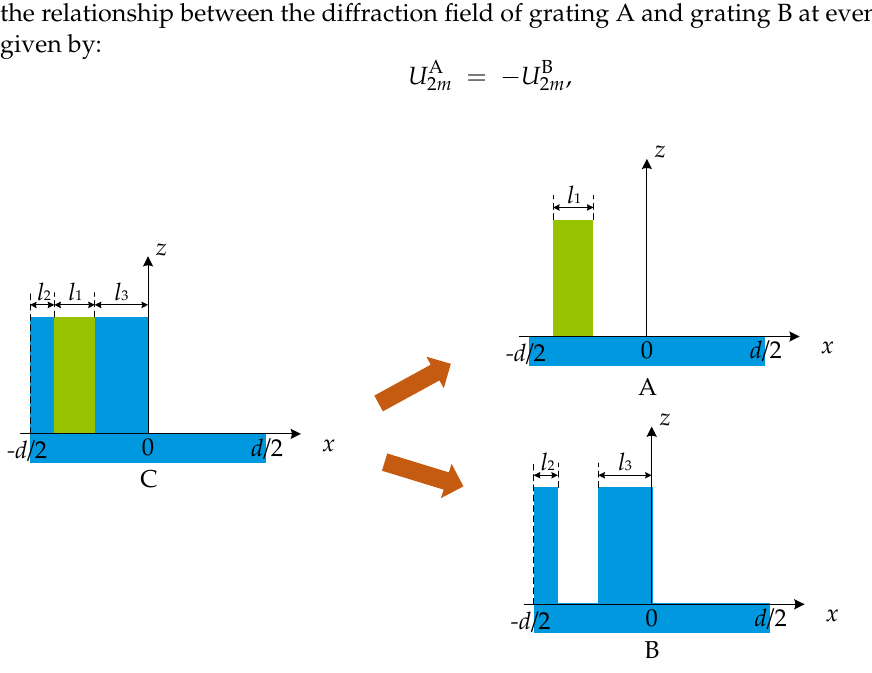
Figure 7. Grating C is divided into grating A and grating B.